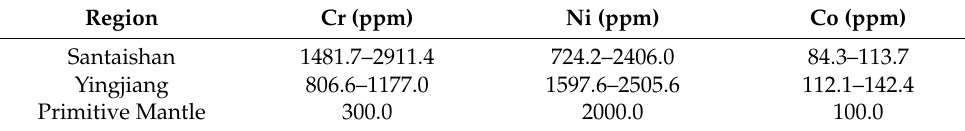
Table 2. Content of highly compatible elements. The Primitive Mantle values are from [46]. Region Cr (ppm) Ni (ppm) Co